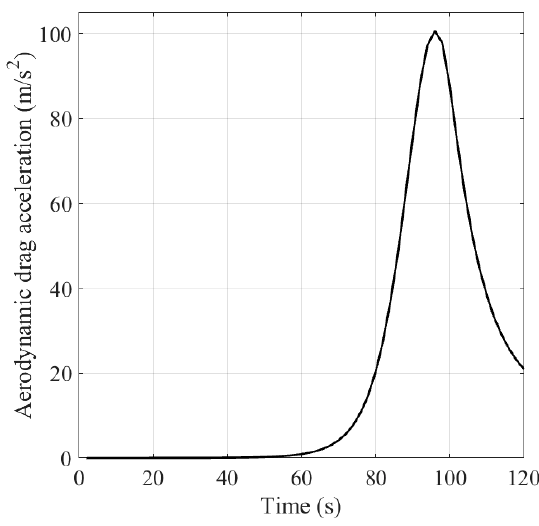
Figure 6. Aerodynamic drag acceleration against time.